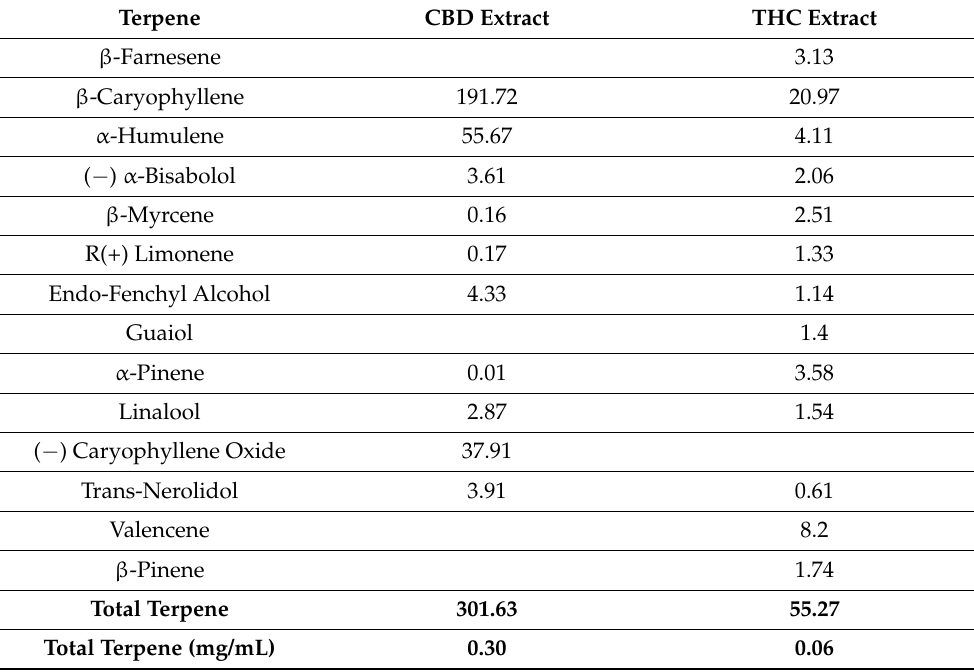
Table 3. Terpene composition of extracts as administered to mice; concentrations are in ppm. Cells with no values represent assay results below the level of detection.